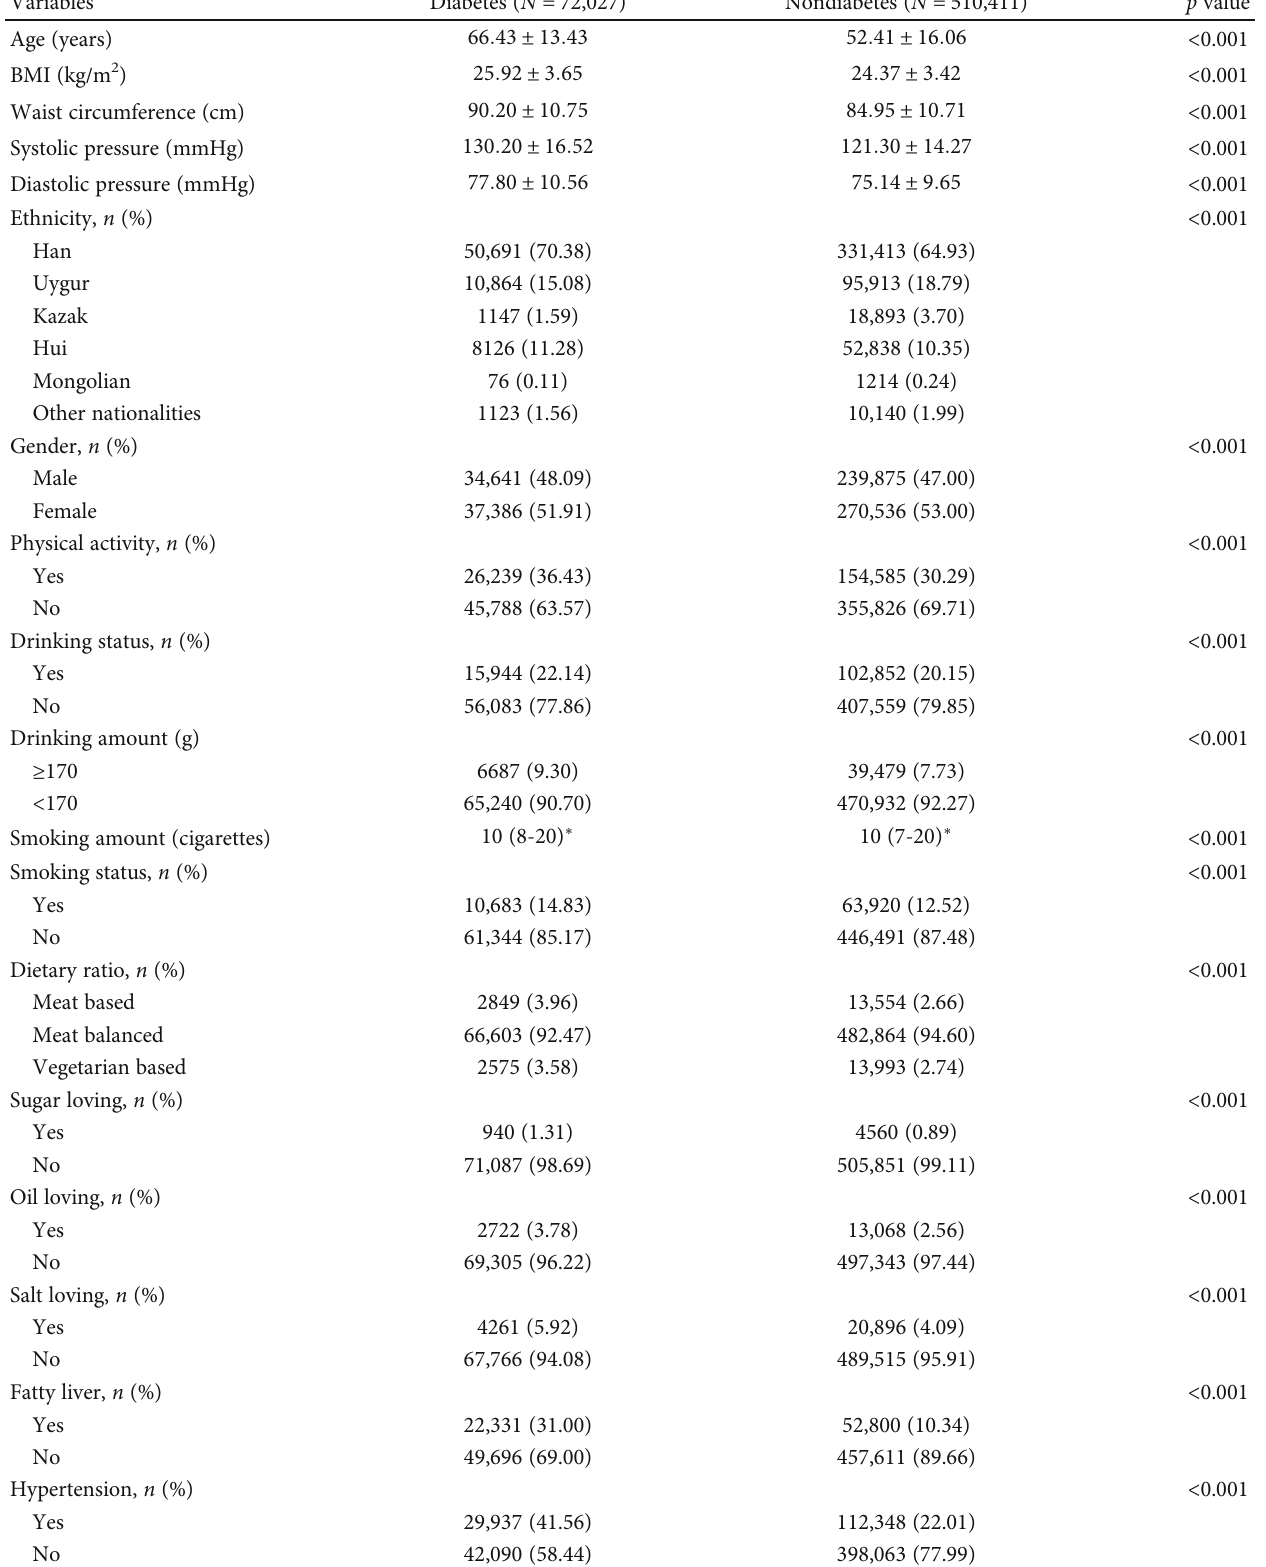
Table 1: Characteristics of